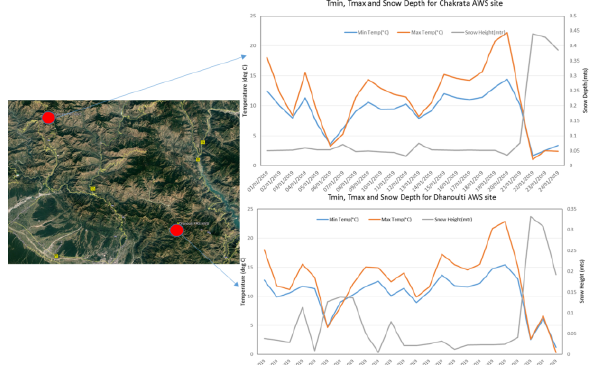
Figure 19. AWS data from Chakrata & Dhanoulti stations of U.K. along with SD data for January 2019.